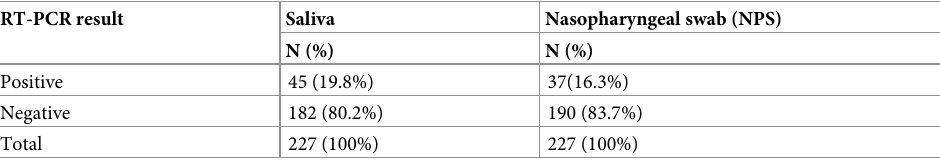
Table 3. Positivity rate of SARS-CoV-2 in saliva and NPS for comparative evaluation of saliva and NPS for SARS-CoV-2 detection using RT-PCR among COVID-19 Suspected patients at Eastern Ethiopia (n =